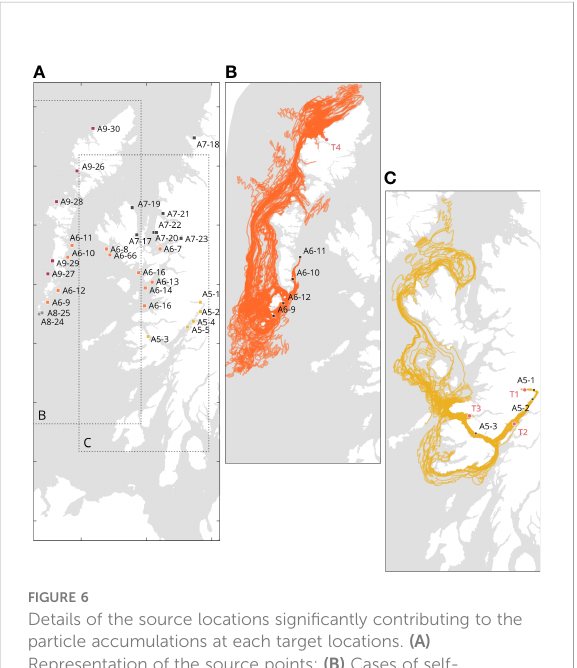
FIGURE 6 Details of the source locations signi fi cantly contributing to the particle accumulations at each target locations. (A) Representation of the source points; (B) Cases of self- recruitment, Loch Eil (T1), and self-recruiting and in fl uence of external recruitment for Loch Linnhe (T2) and Loch Sunart (T3); (C) Example of external recruiting only: Loch Roag (T4). To avoid visual clutter, only the source points A6-9 to A6-12 are illustrated. Distinct colors represent different geographical areas. Details are available in Supplementary Table S4.